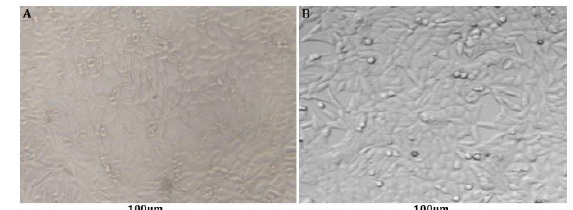
Figure 7. Morphology T47D Cell. A. before treatment,